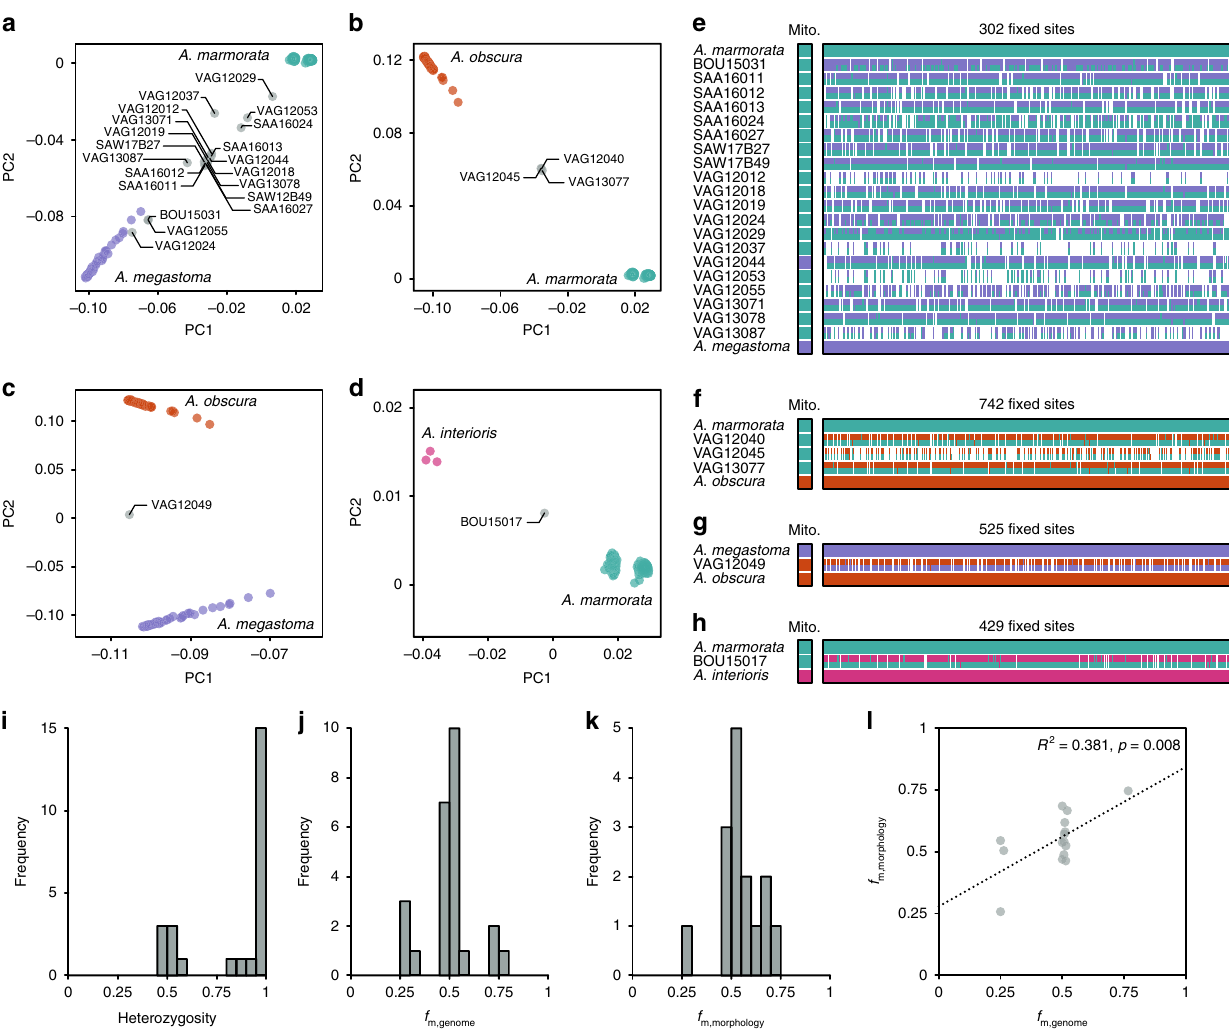
Fig. 2 Contemporary hybridization among tropical eels. a – d Genomic variation inferred in a PCA of all individuals of A . marmorata , A . megastoma , A . obscura , and A . interioris (Supplementary Fig. 5c), shown separately for four hybridizing species pairs: A . marmorata and A . megastoma ( a ), A . marmorata and A . obscura ( b ), A . megastoma and A . obscura ( c ), and A . marmorata and A . interioris ( d ). Individuals with intermediate positions are marked in gray with specimen IDs; species color code is as in Fig. 1. e Ancestry painting for 20 hybrids between A . marmorata and A . megastoma . The top and bottom horizontal bars represent 302 sites that are fi xed for different alleles between the two species; all other bars indicate the alleles at each of those sites. White color indicates missing data. Heterozygous alleles are shown with the top half in each bar matching the second parental species and vice versa. f Ancestry painting for three contemporary hybrids between A . marmorata and A . obscura , based on 742 sites fi xed between these two species. g Ancestry painting for one hybrid between A . megastoma and A . obscura , based on 525 fi xed sites. h Ancestry painting for one hybrid between A . marmorata and A . interioris , based on 429 fi xed sites. i Histogram of heterozygosity observed in hybrids. j Histogram of the proportions of hybrid genomes derived from the maternal species (according to mitochondrial sequence data). k Histogram of the relative morphological similarities between hybrids and the maternal species, measured as the relative proximity to the mean maternal phenotypes, compared to the proximity to the mean paternal phenotype. l Comparison of the proportions of hybrids ’ genomes derived from the maternal species and the similarity to the mean maternal species ’ phenotype. The dotted line indicates a signi fi cant positive correlation between the two measures (two-tailed t test; t = 3.1, p = 0.008, R 2 = 0.381). PC, principal component; mito., mitochondrial genome; AD, distance between the dorsal fi n and the anus; PDH, predorsal length without head; TL, total